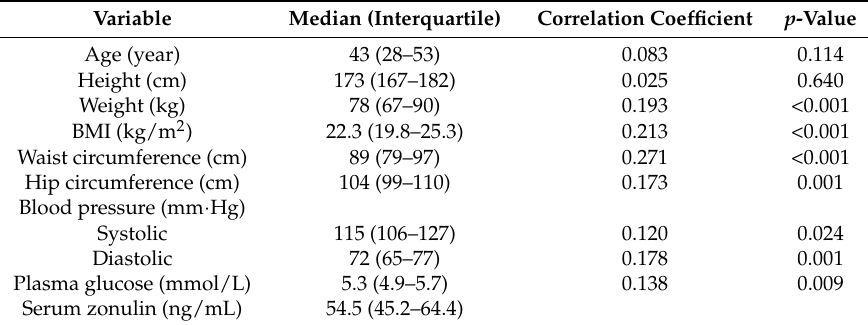
Table 1. Subject characteristics and their correlations with zonulin levels.